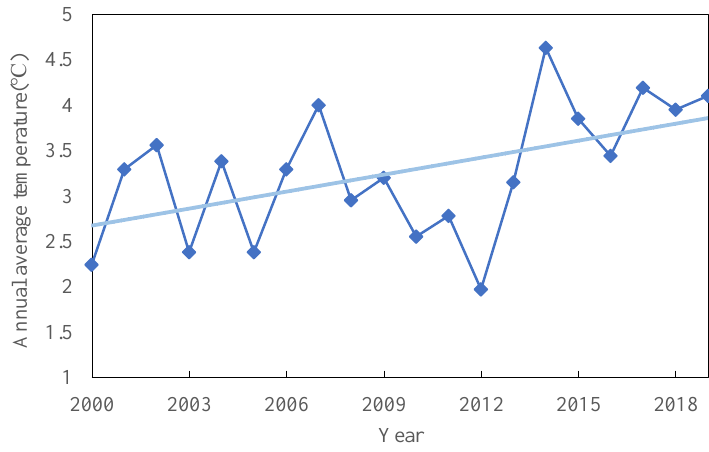
Figure 16. Annual average temperature change curve.